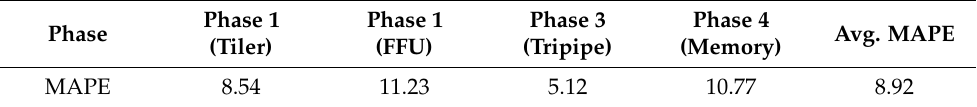
Table 6. Results of GPU per-phase power models (unit: MAPE (%)). Phase